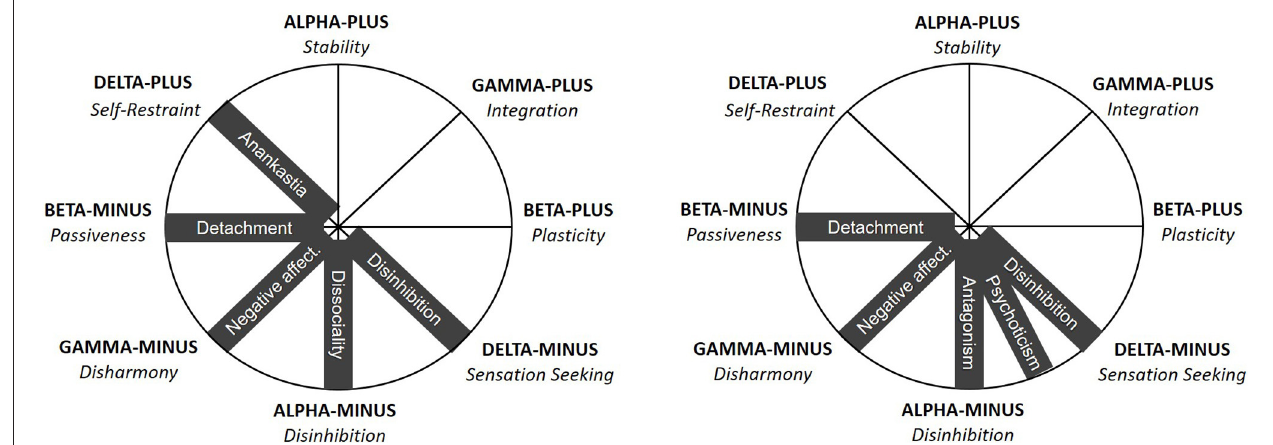
FIGURE 3 | Location of the pathological traits from the ICD-11 (on the left) and DSM-5 (on the right) models within the Circumplex of Personality Metatraits. Pathological traits are depicted on black background. The location of the Disinhibition domain in both ICD-11 and DSM-5 models within Delta-Minus/Sensation Seeking rather than Alpha-Minus/Disinhibition is justified by the meaning of these